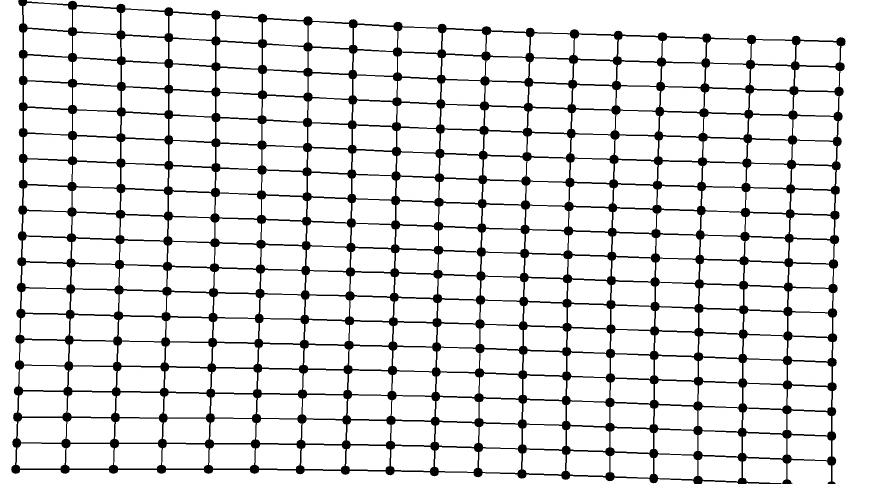
Figure 22. Generated synthetic image example.